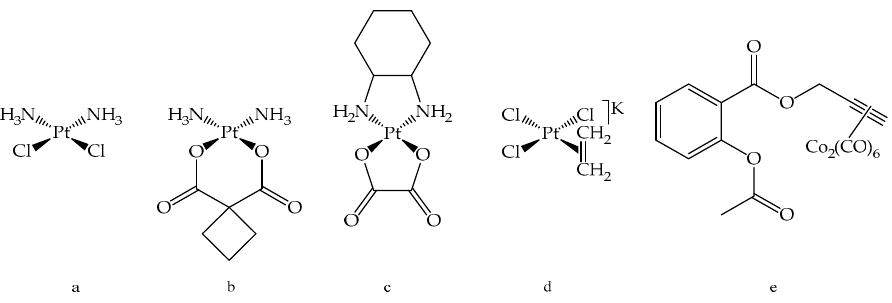
Figure 1. ( a ) Cisplatin, ( b ) Carboplatin, ( c ) Oxaliplatin, ( d ) Zeise’s salt, and ( e ) Co-ASS.